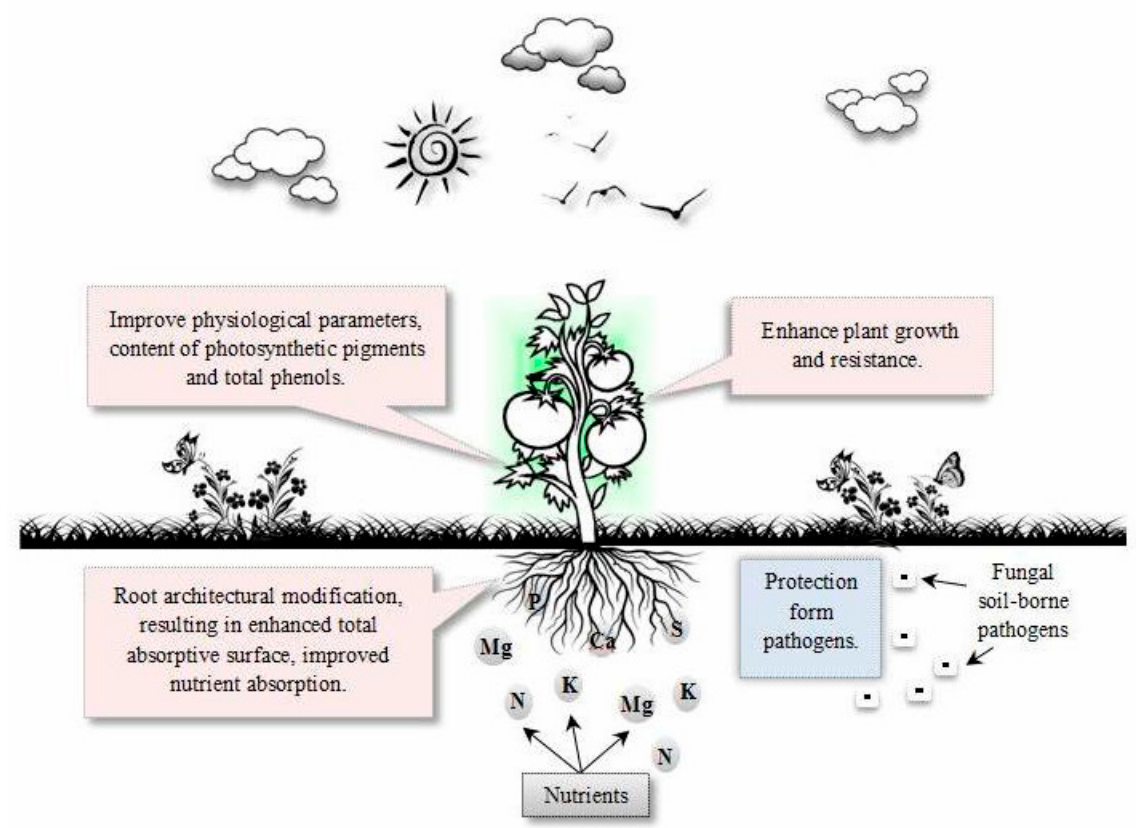
Figure 6. Graphical diagram representing the beneficial roles of Trichoderma spp. in cherry tomato nutrition and growth. Table 4. Total phenolic content and photosynthetic pigments (chlorophyll a, b, and total carotenoids), of cherry tomato plants grown under greenhouse conditions with and/or without F. solani infested soil, as affected by different Trichoderma